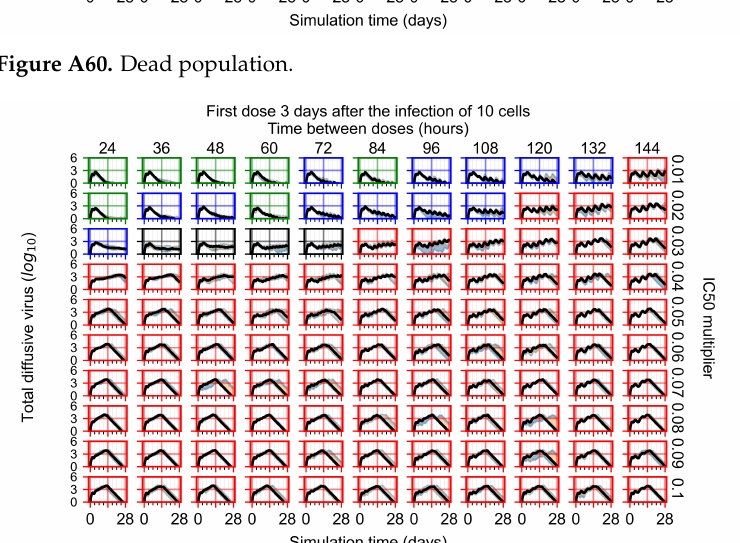
Figure A60. Dead population.